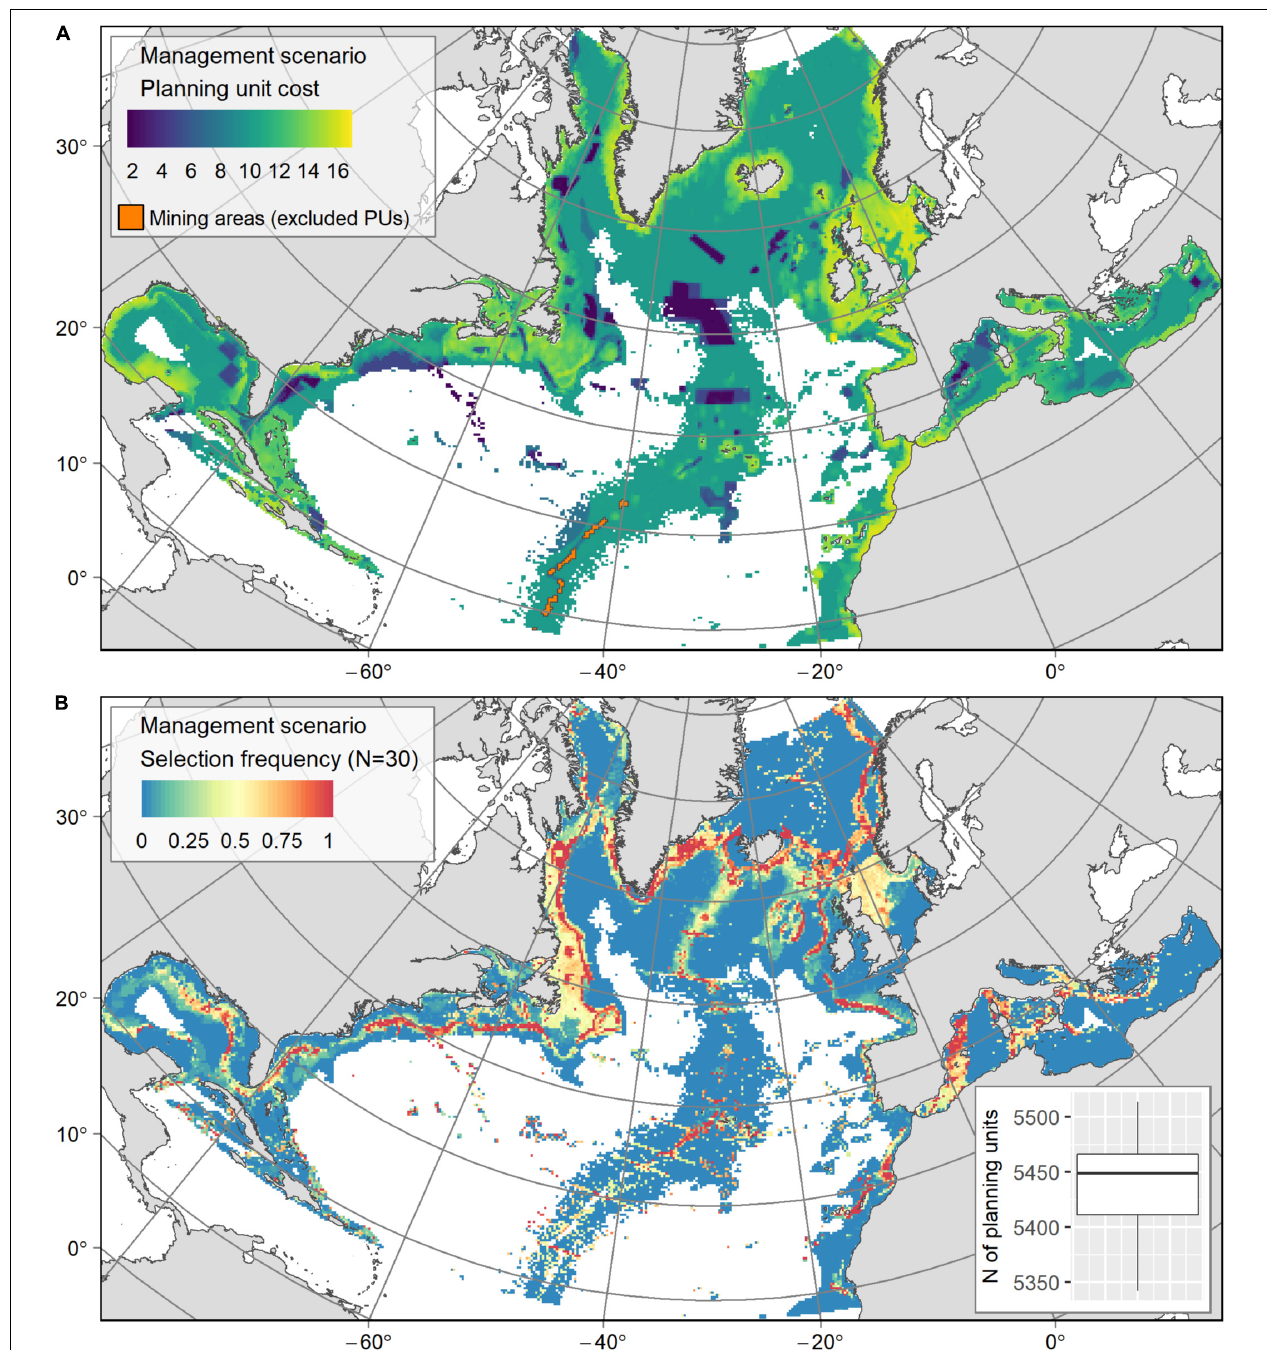
FIGURE 6 | (A) Socio-economic cost layer used in the “Management” scenario, generated from the distribution of bottom fishing catch, the presence of MPAs or CBD EBSAs and the VME confidence index. Blue PUs (cost lower than 6) highlight the MPAs in which the fishing catch was relatively low, while yellow PUs reveal areas of high fishing catch. PUs containing deep-sea mining activities (in orange) were excluded from the conservation solutions. (B) Output from the “Management” scenario: map of PU selection frequency from the 30 solutions with a boxplot showing the number of PUs in the